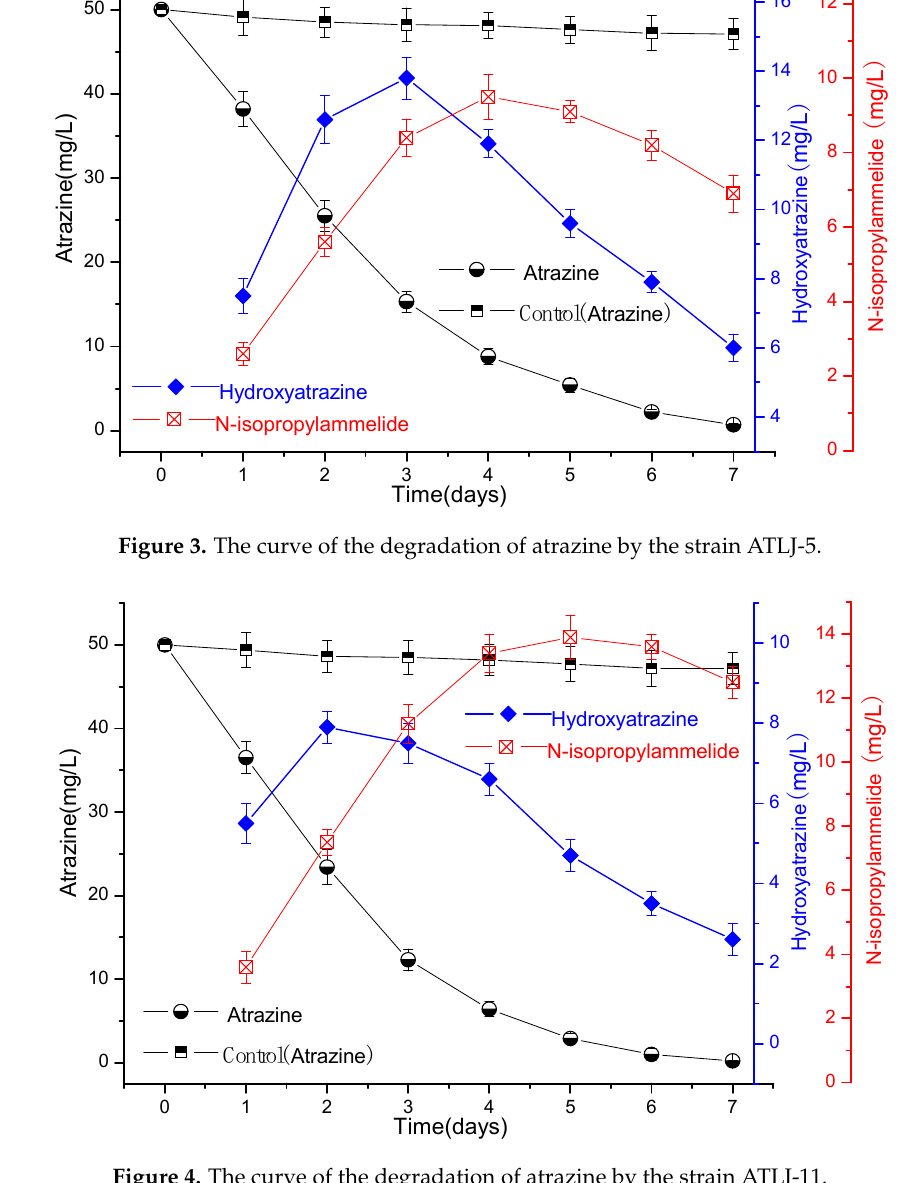
Figure 4. The curve of the degradation of atrazine by the strain ATLJ-11.